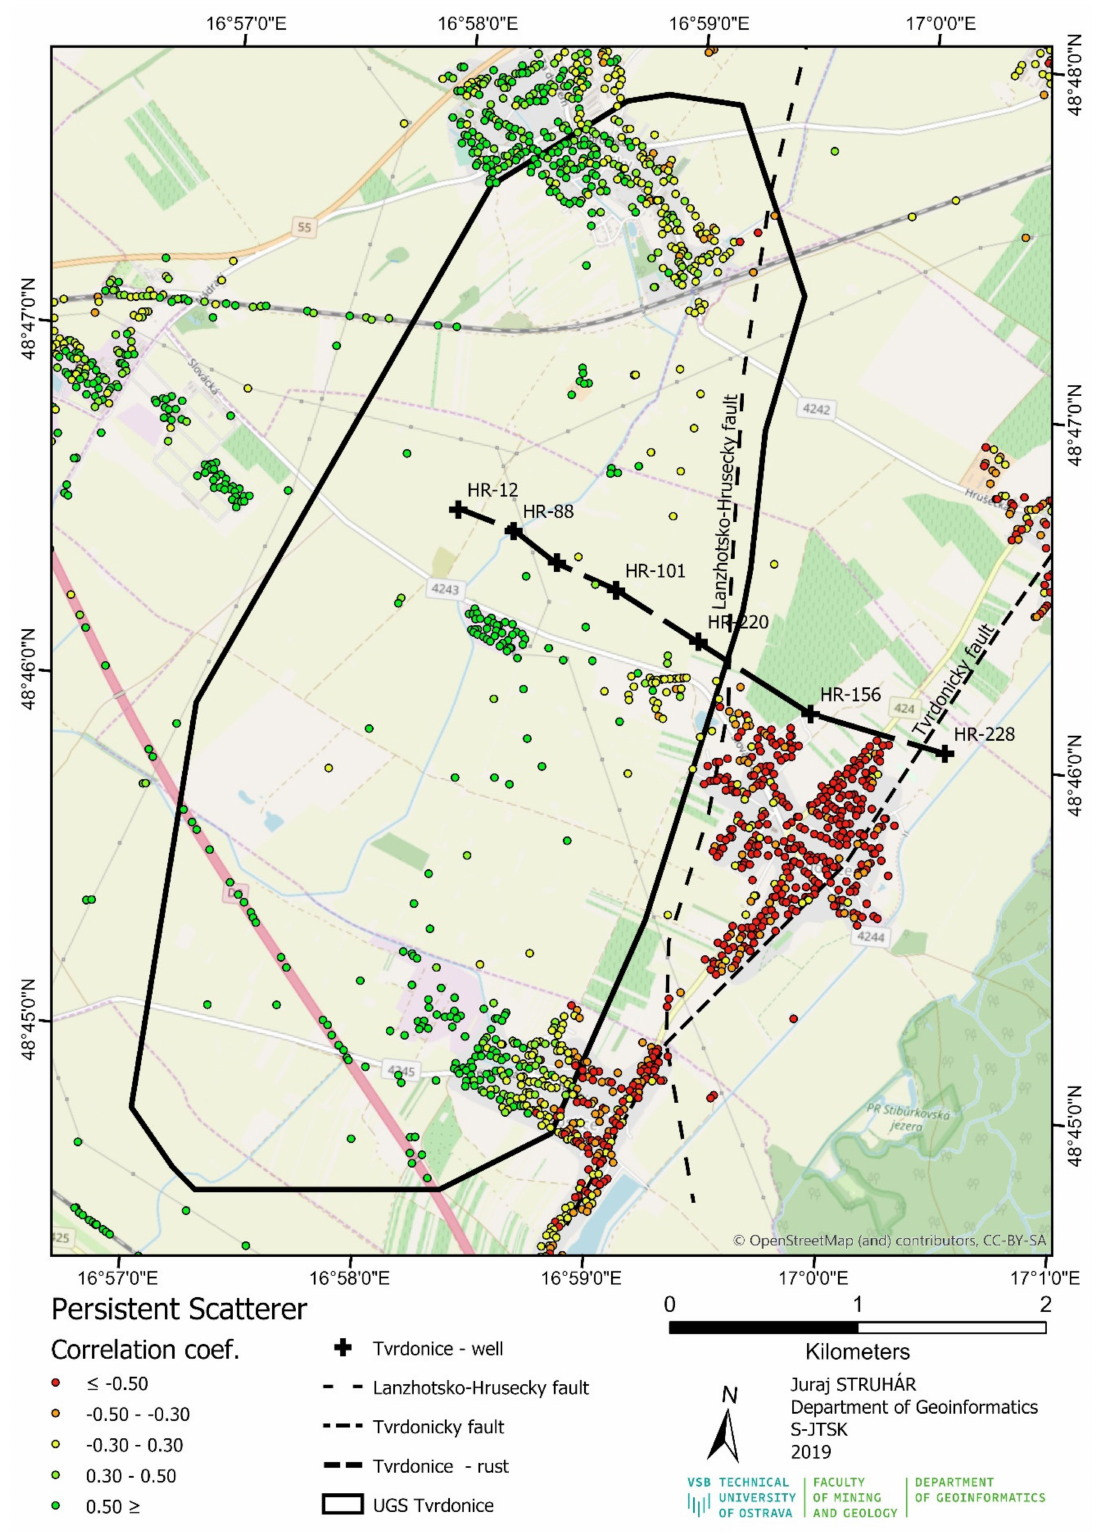
Figure 4. Example of distribution of correlation coe ffi cient r values for the UGS Tvrdonice computed for every PS point; in the figure, it is showed the Tvrdonice fault and Lunžhotsko–hrušeck ý fault and drawing of course of the geological cross-section from Figure